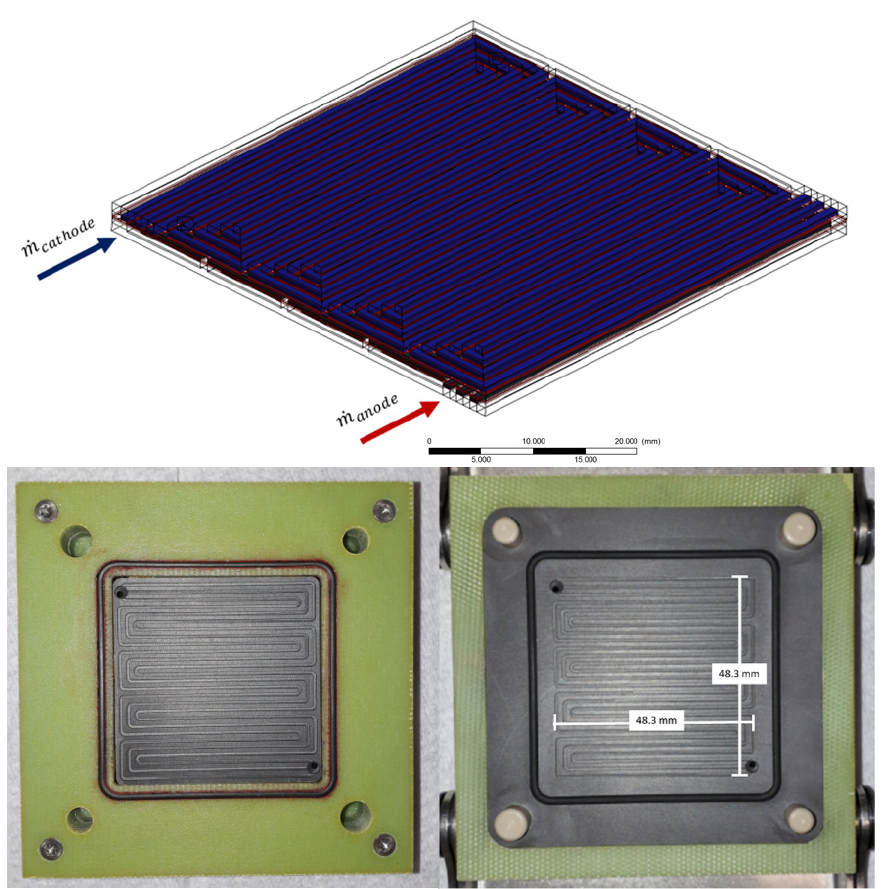
Figure 2. Numerical domains ( above ) and the experimental geometry ( below ) of the anode and cathode flow fields.